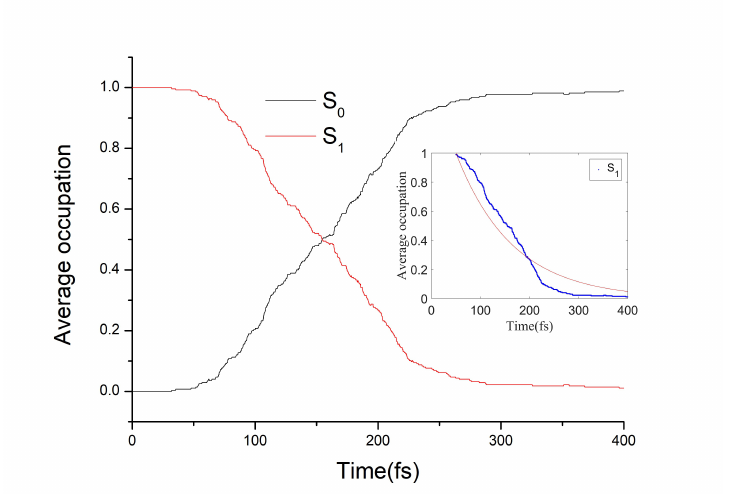
Figure 3. Average occupation of the electronic states S 0 and S 1 as a function of simulation time. The occupation of the S 1 excited state over time fitted by the exponential function is shown in the